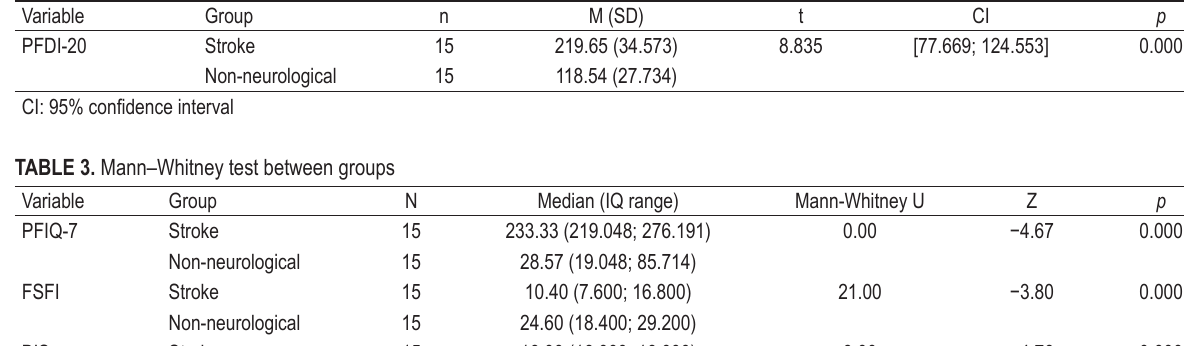
TABLE 2. Student t‑test for PDFI‑20 between groups Variable